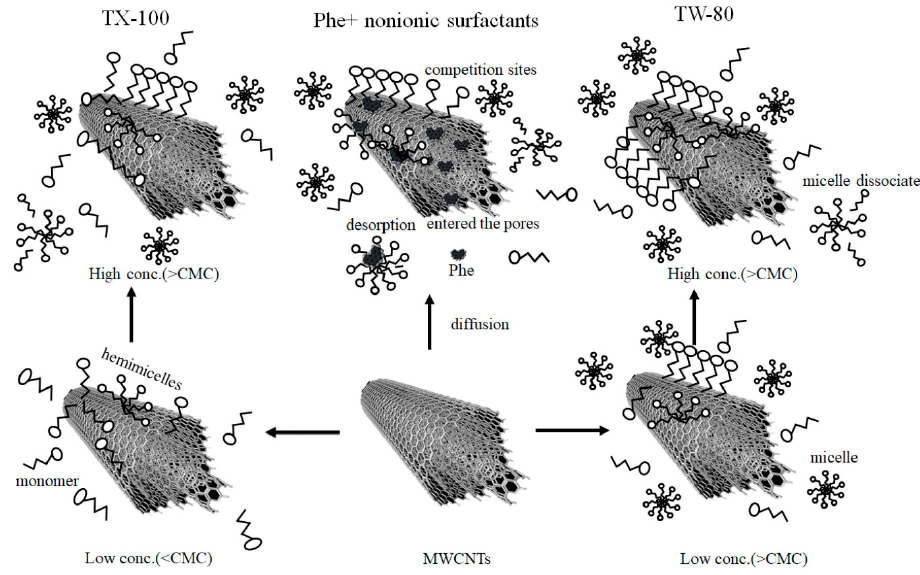
Figure 5. Scheme of adsorption mechanisms of phenanthrene adsorbed onto MWCNTs as affected by nonionic surfactants. nonionic